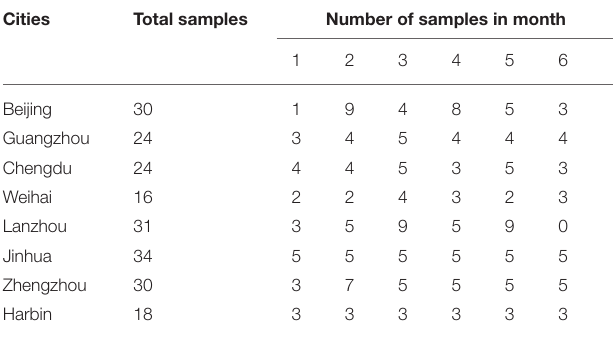
TABLE 1 | Number of samples obtained from the hospitals in eight cities in China.